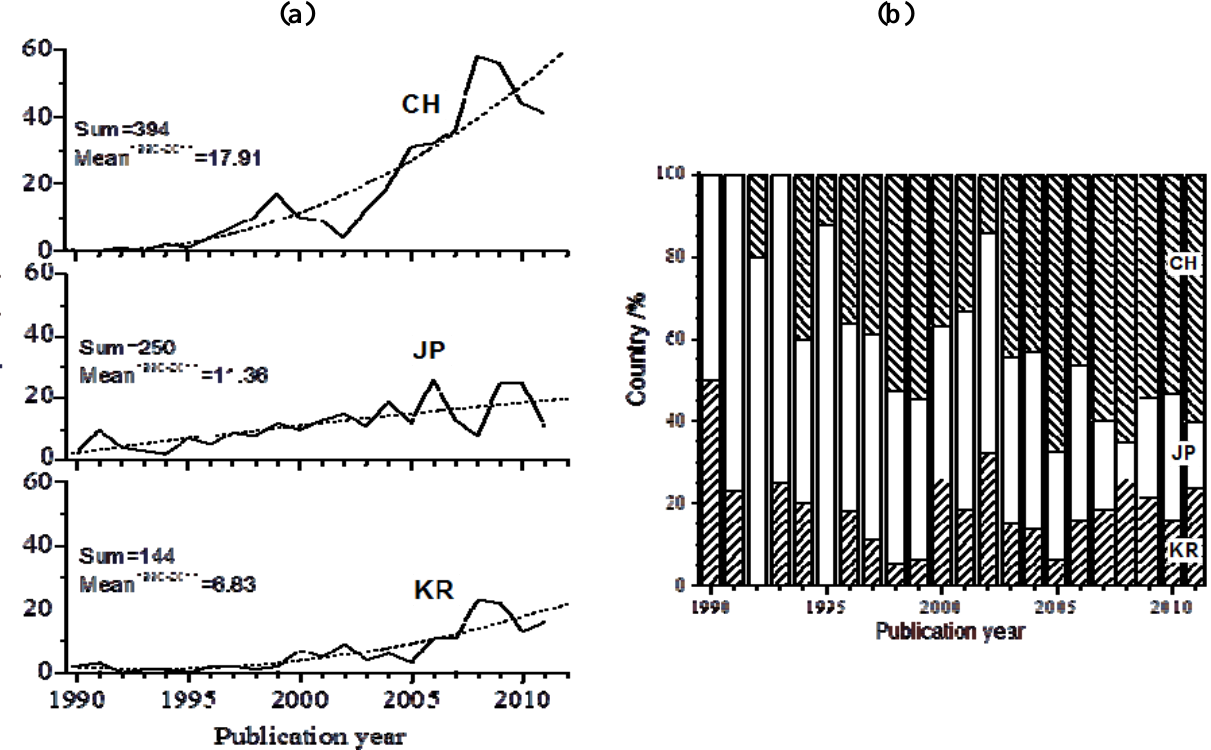
Figure 1. ( a ) Trend in R&D production (as number of research outputs or papers) by countries; ( b ) Proportion of national publication output produced between 1990 and